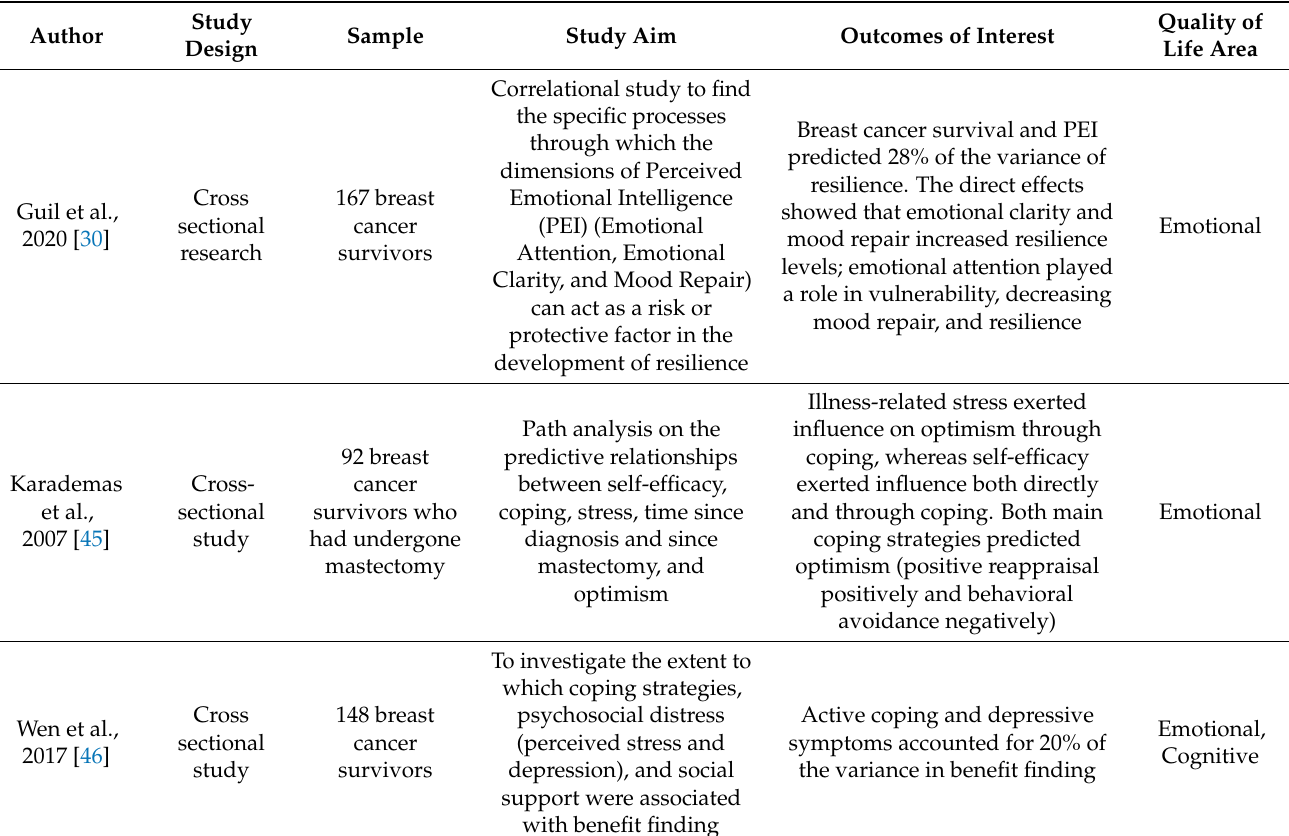
Table 2. Synthesis of studies included in the review according to study design, sample, aim, outcomes of interest. The “Quality of life area” column refers to the dimension(s) of quality of life that are affected by the study, taking into consideration the outcome